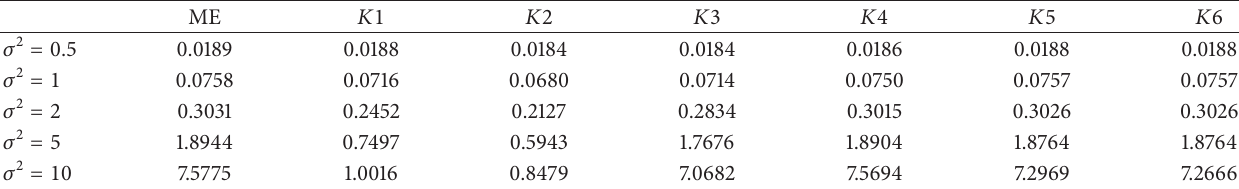
Table 14: Estimated MSE with 𝑛 = 50 , 𝑝 = 6 , and 𝛾 = 0.85 .